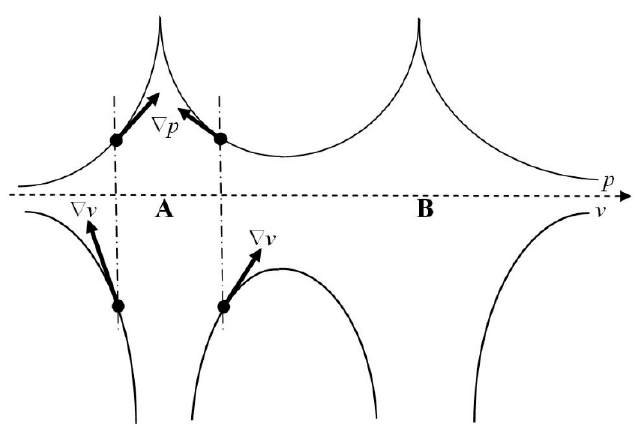
Figure 1. Schematic diagram of the axial (bond) profiles, in section containing the “ z ” direction of the coordinate system (along the bond axis), of the external potential ( v ) and electron probability ( p ) in a diatomic molecule A–B demonstrating a negative character of the scalar product ∇ p ( r ) ·∇ v ( r ). It confirms the negative equilibrium contribution σ Ieq. (axial) of the resultant gradient information (Equations (A20) and (A21)) and positive source σ Meq. (axial) of the resultant gradient entropy (Equation (A24)) in the bond formation process, due to the equilibrium current of Equation (18), j eq. ( r ) ∝ −∇ p ( r ).